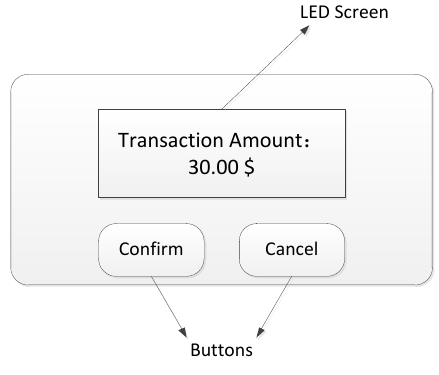
Figure 2. The design of the LED